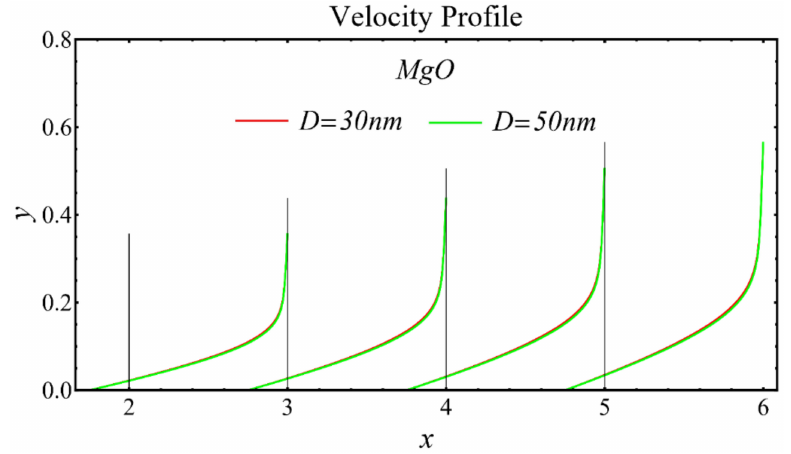
Figure 11. Velocity profile of MgO-EG nanofluid under influence of nanoparticle diameter.